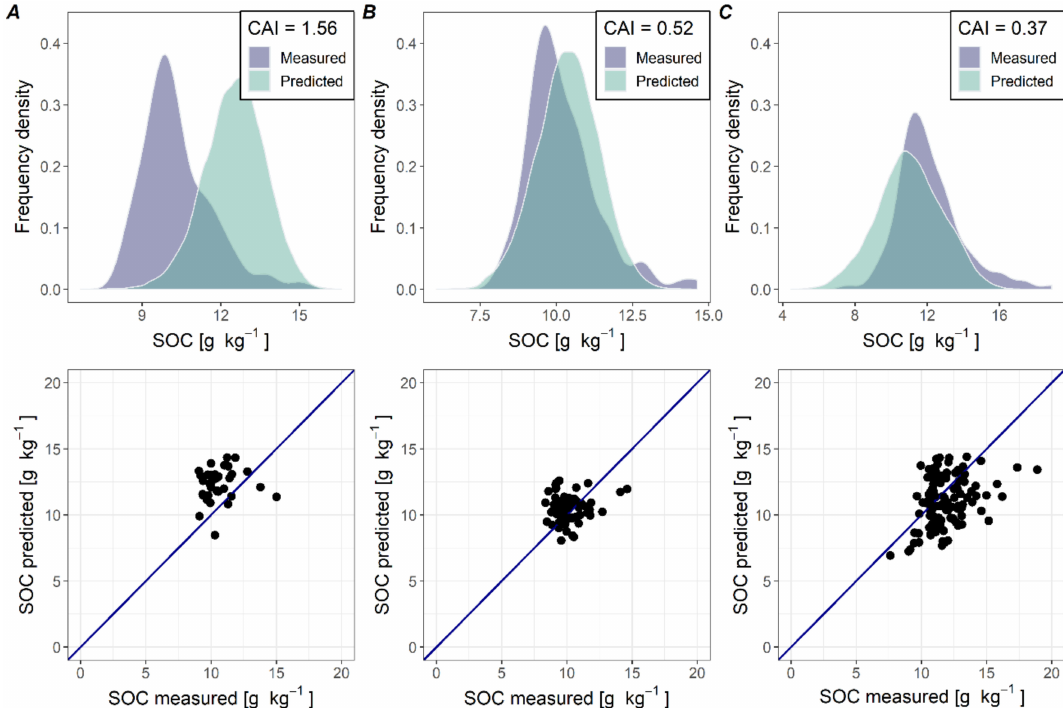
Figure 8. Comparison of the predicted SOC obtained from the Partial Least Squares Regression (PLSR) model and the measured SOC values in the ( A ) Sicy, ( B ) Hostellerie and ( C ) Ernage fields, and their respective Cellulose Absorption Index (CAI) values. The blue lines in the plots below are the 1:1 line. See Figure 1 for the location of the fields and Figure 2 for the location of the sampling